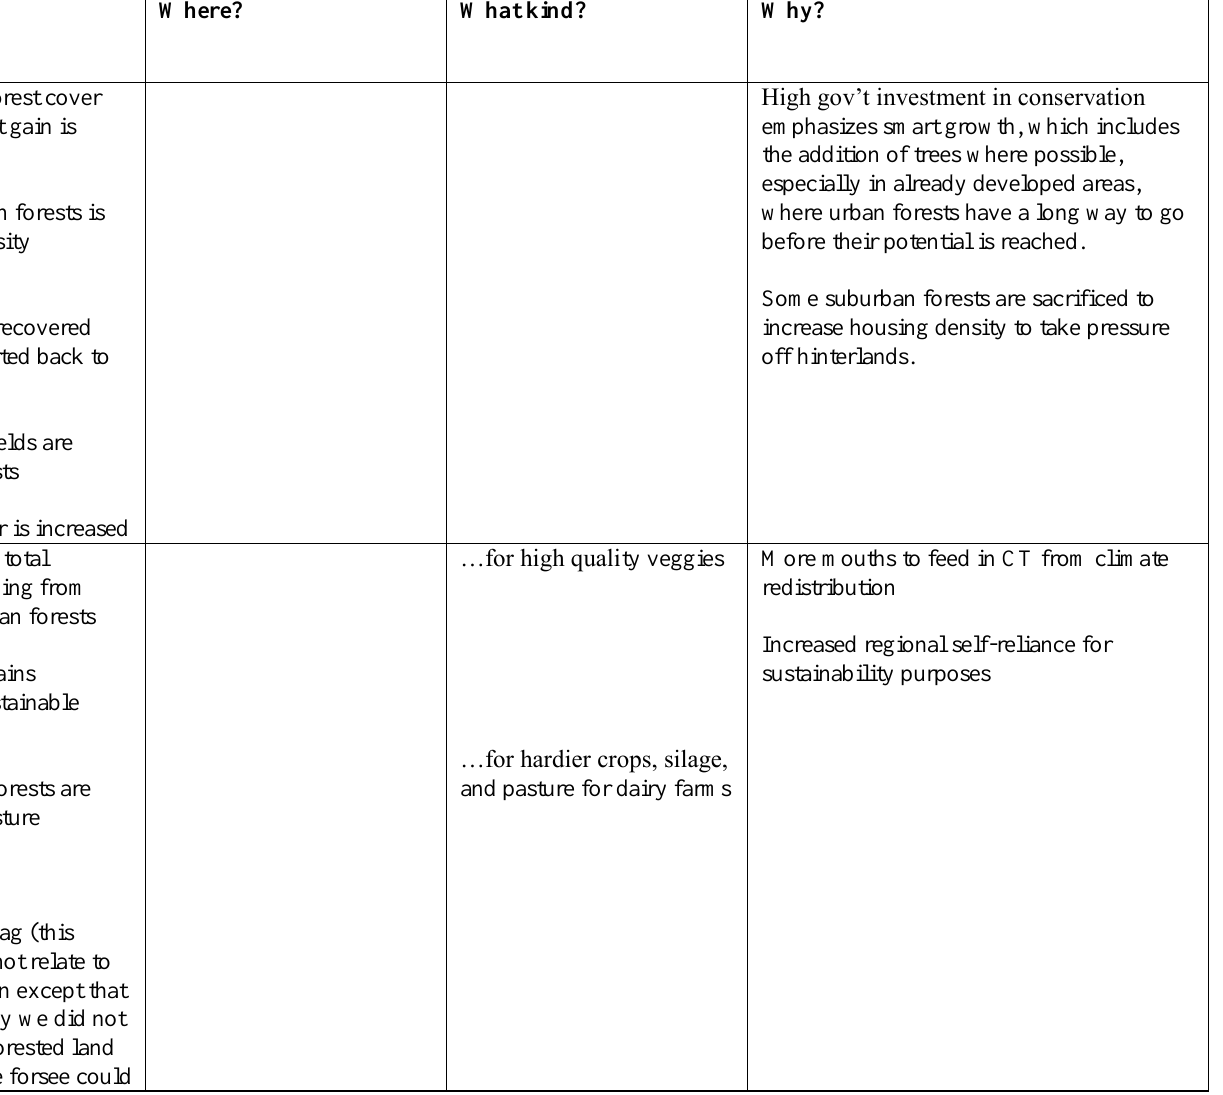
Table A2.14. Scenario 2: New Yankee Urbanism Land